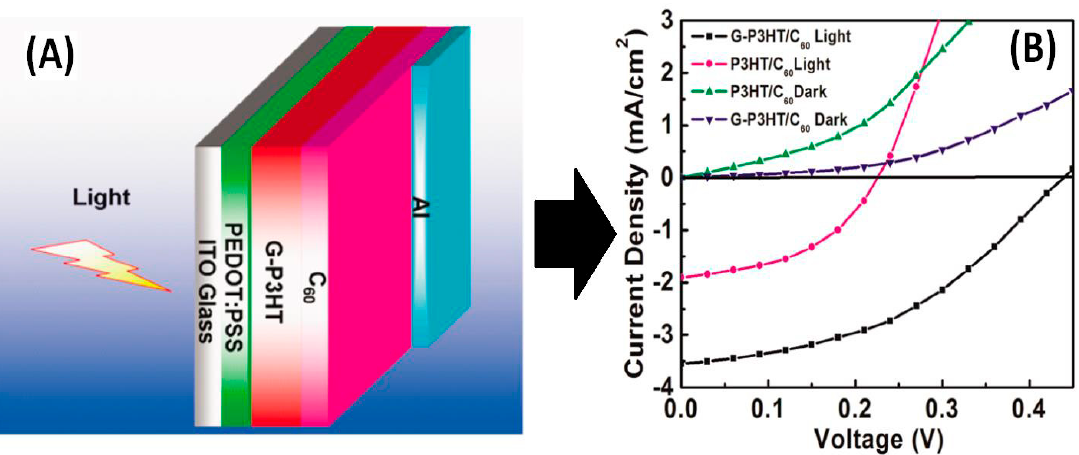
Figure 6. ( A ) Schematic representation of ITO/PEDOT:PSS/G-P3HT:C 60 /Al PSC; and ( B ) J–V characteristics using P3HT:C 60 or G-P3HT:C 60 as the active layer. Reproduced with permission from Ref. [64].